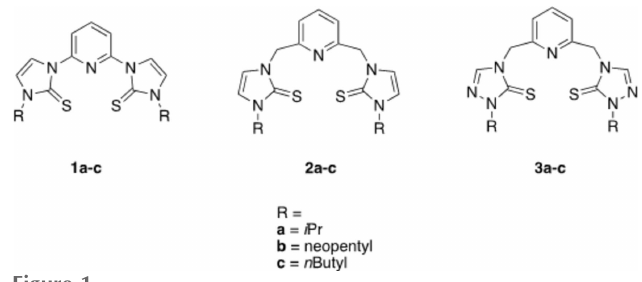
Figure 1 SNS ligand precursors prepared by Miecznikowski et al. (2011,